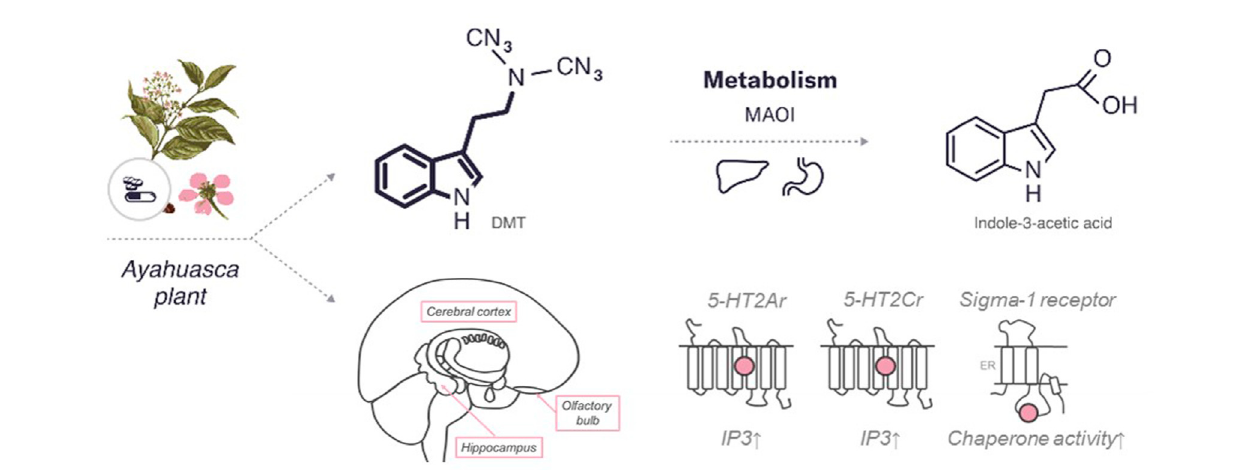
FIGURE3| AnoverviewofthecharacteristicsofDMT.ThediagramincludesthechemicalstructuresofDMTanditsmetabolite.Theboldlinesindicatesimilaritiesin the chemical structure between this psychedelic and serotonin. In addition, the enzymes and major organs involved in the metabolism and excretion of psilocybin are indicated. The mechanism of action represents the targets of the psychedelic, both the region of the brain affected by the psychedelic and the receptors with which it interacts (pink circle for agonist). 5HT — serotonin receptors (2Ar, 2Cr, — subtypes), sigma 1 receptor. MAOI, monoamine oxidase I; IP3, inositol-3-phosphate; ER, endoplasmic